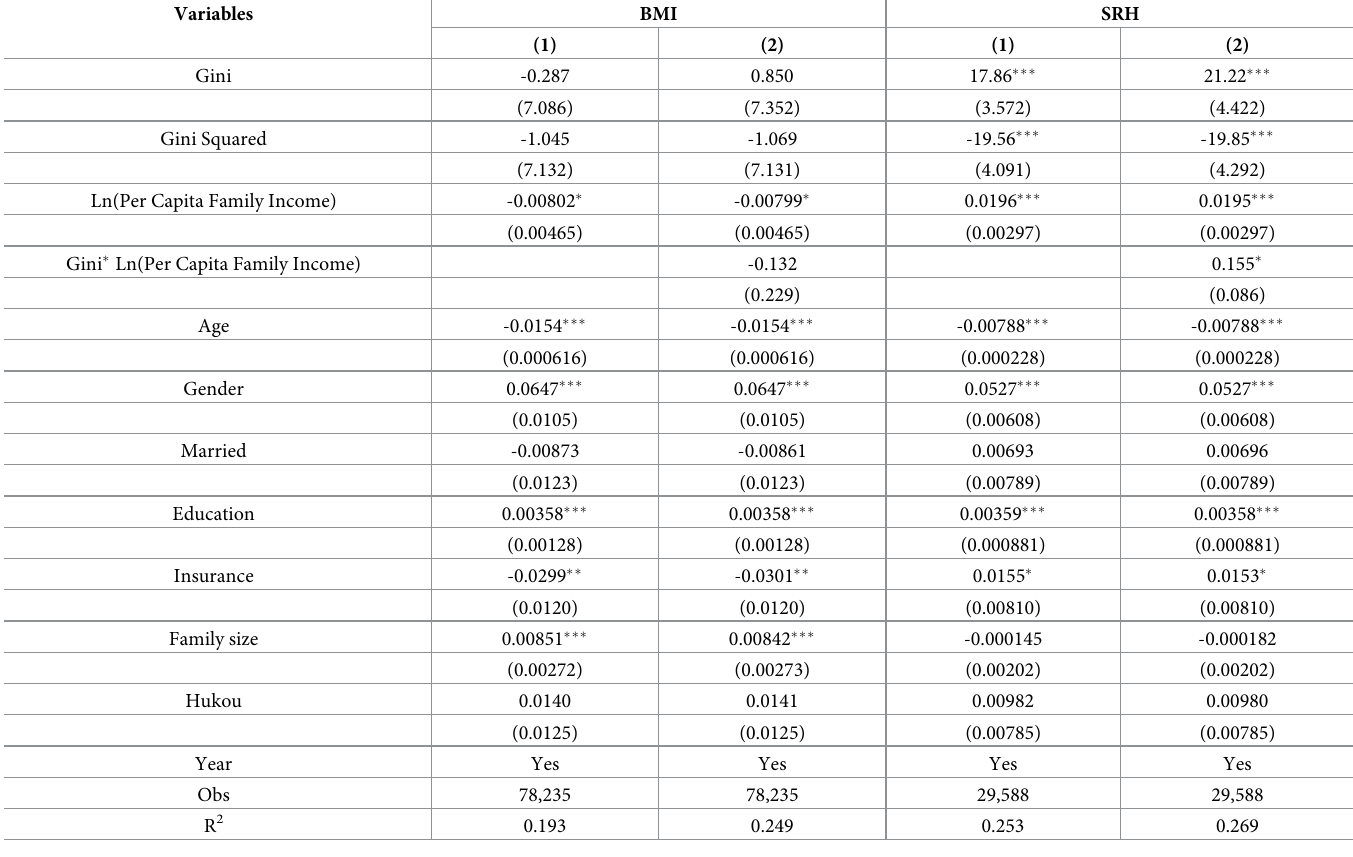
Table 5. The effects of Gini coefficient on BMI and